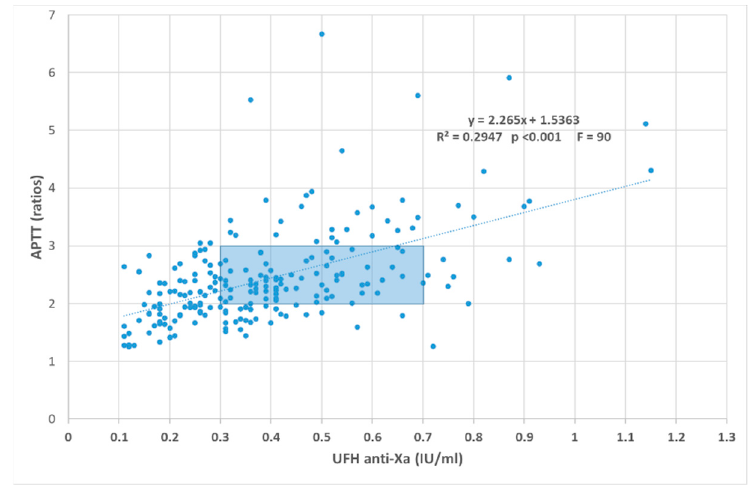
Figure 1. Real-world relationship between UFH anti-Xa (Liquid anti-Xa, Stago) and STA-PTT-A (Stago), a highly sensitive to heparin APTT reagent, in 218 samples from ICU COVID-19 patients. Therapeutic consensus area is highlighted. The D-dimers, fibrinogen, CRP, and platelets levels have no influence on this relationship (comparison of the data pairs for which the parameter of interest (D-dimers, fibrinogen, CRP, and platelets) is, respectively, below the 25th or above the 75th percen- tiles).